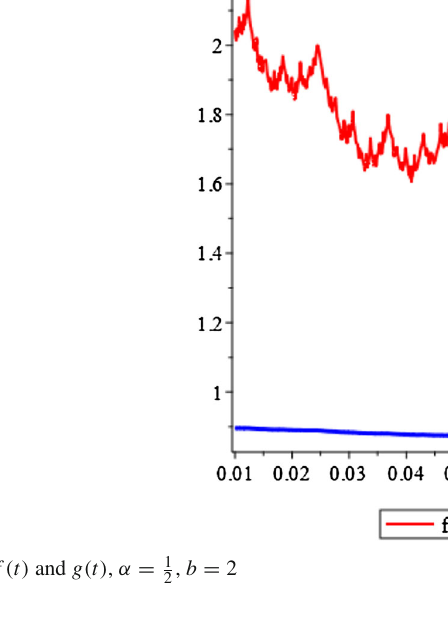
Fig. 1 f ( t ) and g ( t ) , α = 1